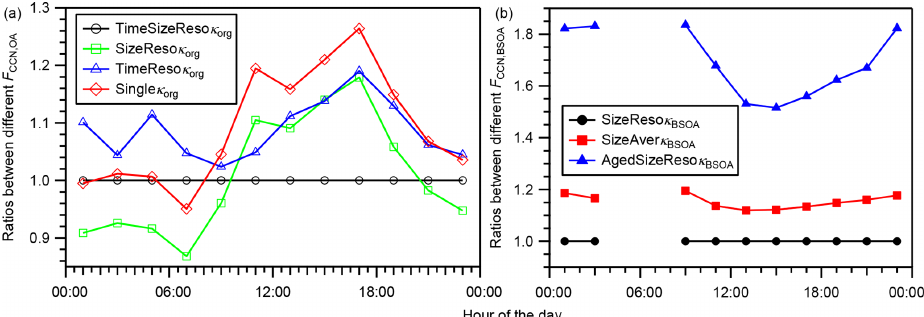
Figure 7. (a) Diurnal variation in the ratios of the F CCN , OA derived using time- and size-resolved κ org (TimeSizeReso κ org ), time-averaged and size-resolved κ org (SizeReso κ org ), size-averaged and time-resolved κ org (TimeReso κ org ), and time- and size-averaged κ org (Single κ org ) to that derived using the time- and size- resolved κ org (TimeSizeReso κ org ). (b) Diurnal variation in the ratios of the F CCN , BSOA derived using size-resolved κ BSOA (SizeReso κ BSOA ), size-averaged κ BSOA (SizeAver κ BSOA ), and aged size-resolved κ BSOA (AgedSizeReso κ BSOA ) to that derived using the size-resolved κ BSOA (SizeReso κ BSOA ). In panel (b) , the condition of aged size-resolved κ BSOA assumes that the value of κ BSOA equals that of κ ROA , and the data during 04:00–08:00JST, when the concentration of BSOA was low (volume concentration less than 0 . 01 × 10 − 6 cm 3 m − 3 ), are not presented (data are presented in Table